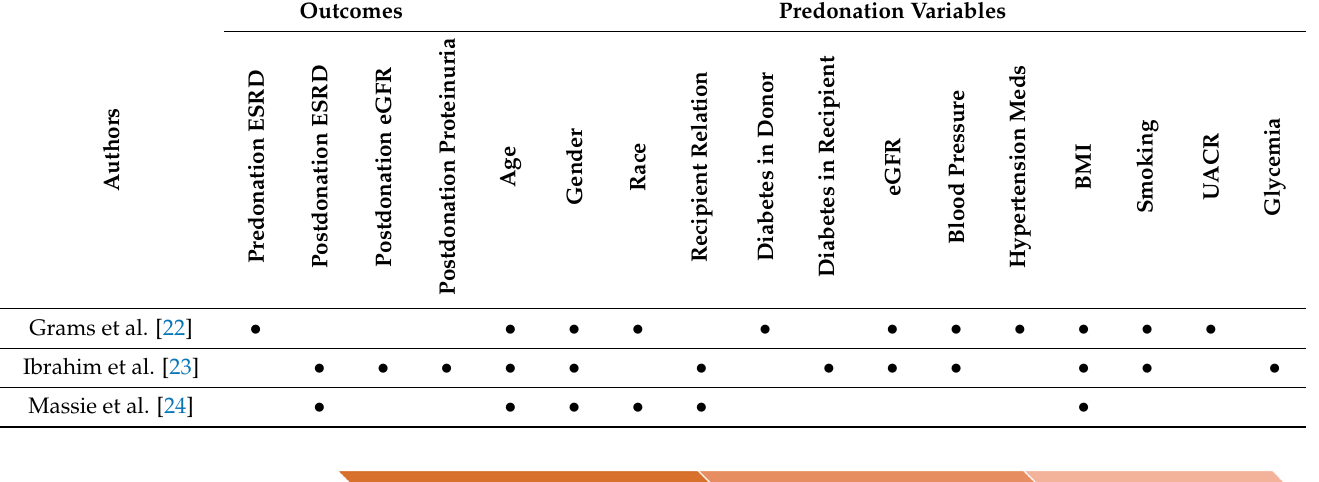
Table 1. Pre-donation and post-donation risk prediction tools (the dots indicate the variable or result is included in the tool).